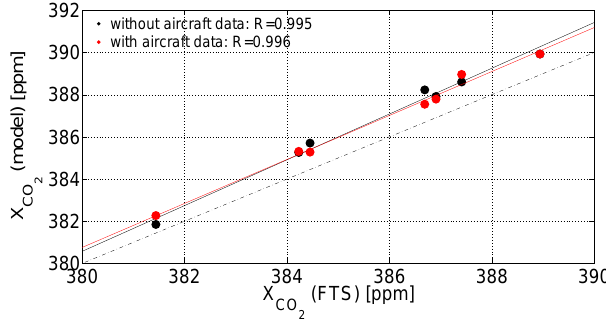
Fig. 13. Scatter plot of the CO 2 total column averages calculated with the extended aircraft profiles in comparison to the original model data. Using the low-level aircraft profile measurements leads to a slightly better estimation of the X CO 2